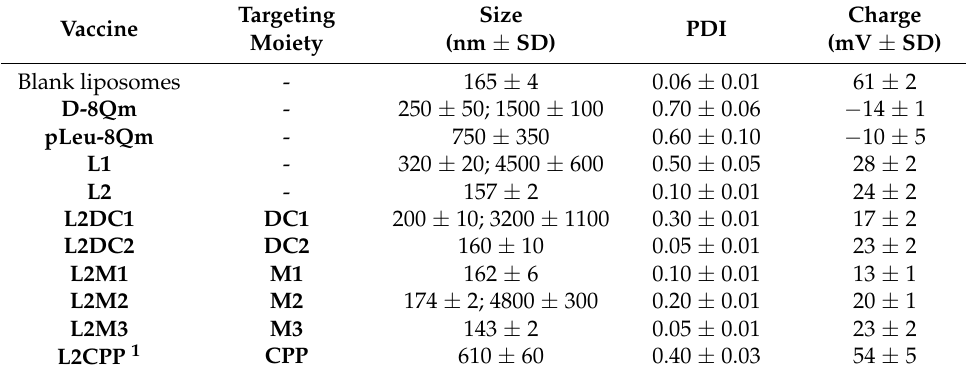
Table 1. Physicochemical characterization of vaccine